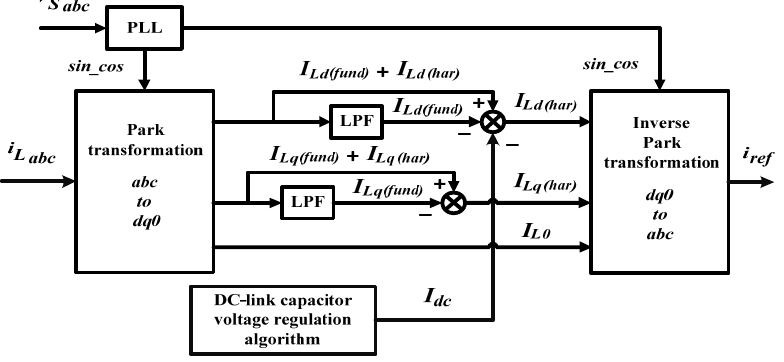
Figure 3. Control structure of a typical synchronous reference frame (SRF) algorithm [17,24].